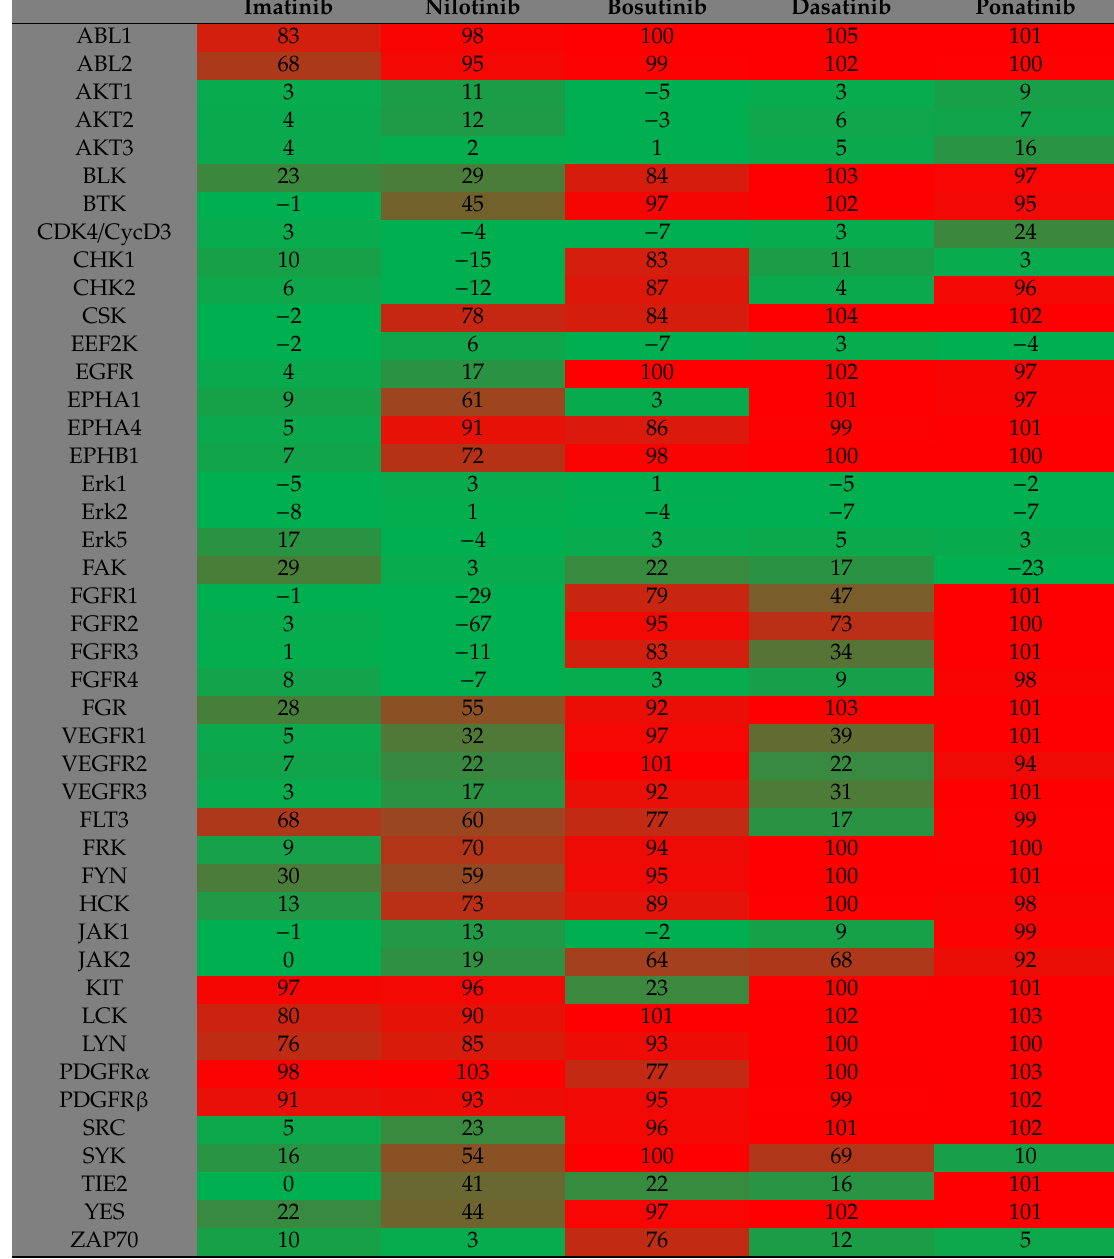
Table 1. Tyrosine kinase inhibitors (TKI) specificity and extent of inhibition. Imatinib